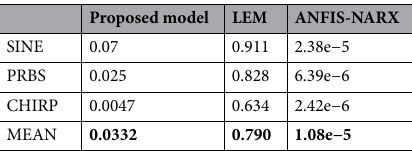
Table 4. NMSE of the proposed method in comparison with the LEM and ANFIS–NARX methods for PRBS training data set.